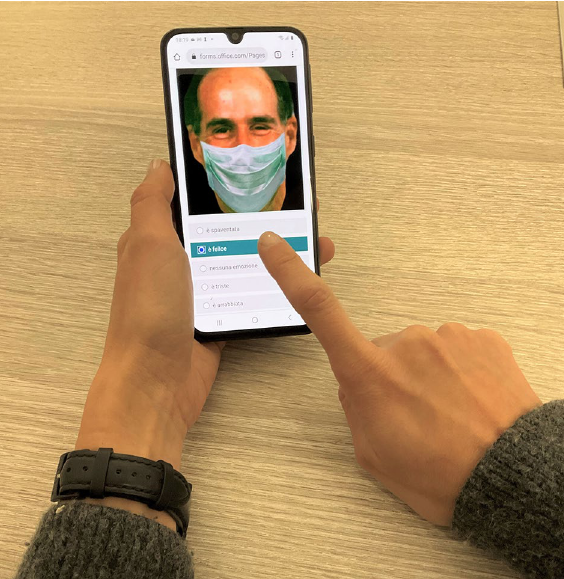
Figure 2. Experimental procedure. Participants were asked to identify the correct facial emotion by choosing between five possible randomized options: happy, sad, fearful, angry, and neutral. Each face was displayed on the screen of personal smartphones for as long as it took to provide the response by holding the index finger against the touch screen. Face images were obtained with permission from the ER-40 colour emotional stimuli public database 29,30